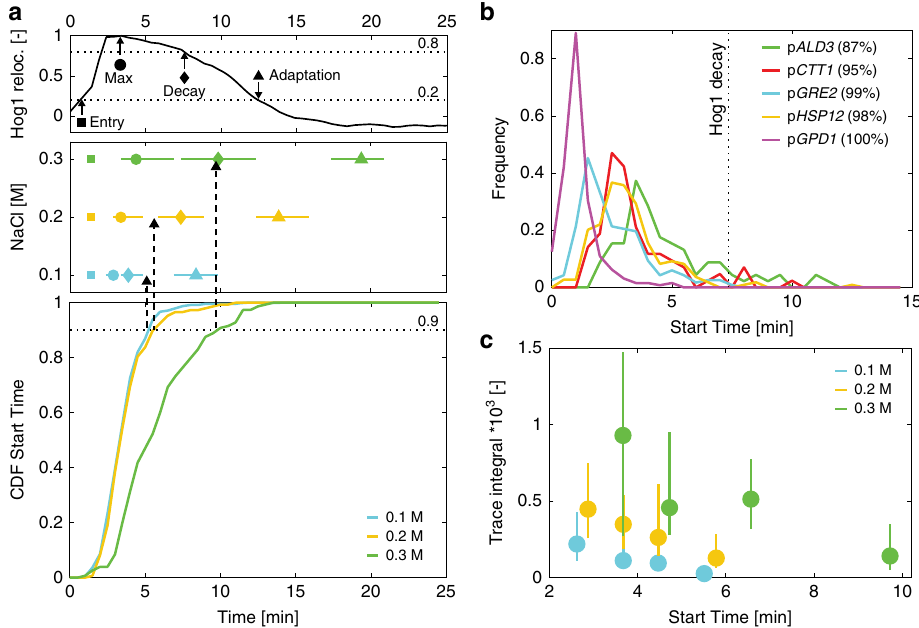
Fig. 3 Early Hog1 activity dictates promoter activation and output. a In Hog1 nuclear relocation traces obtained from single cells, the timing of Hog1 nuclear entry (square), maximum enrichment (circle), start of the decay in nuclear enrichment (diamond) and Hog1 adaptation (triangle) can be identi fi ed (upper panel). The median (marker) and 25th to 75th percentiles (lines) for these measurements performed on a population of more than 300 cells are plotted for three different osmotic stresses (central panel). The cumulative distribution functions of Start Times for the p STL1 -PP7sl reporter for these same three concentrations are plotted (lower panel). b Histograms of Start Times following a 0.2 M stress for the fi ve other promoters tested. The vertical dashed line represents the median decay time of Hog1 measured at 0.2 M. The number in the legend indicates the percentage of cells, which have initiated transcription before the median Hog1 decay time. c The population of p STL1 -PP7sl positive cells is split in four quartiles based on their Start Time. The median (circle) and 25th to 75th percentiles (line) of the integral of the PP7 trace is plotted for each quartile of at least 50 cells. Source data are provided for a